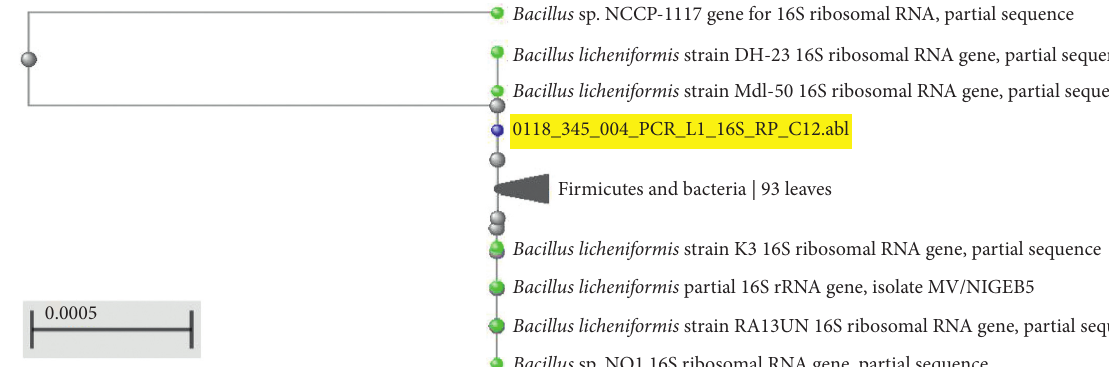
Bacillus licheniformis strain K3 16S ribosomal RNA gene, partial sequence Bacillus licheniformis partial 16S rRNA gene, isolate 0.0005 Bacillus licheniformis strain RA13UN 16S ribosomal RNA gene, partial sequence Bacillus sp. NO1 16S ribosomal RNA gene, partial sequence Figure 6: Phylogenetic tree based on partial sequence of 16S ribosomal RNA gene for Sample L1 (highlighted yellow color) showed that the amylase-producing bacteria was Bacillus licheniformis based on the first five identities and phylogenic